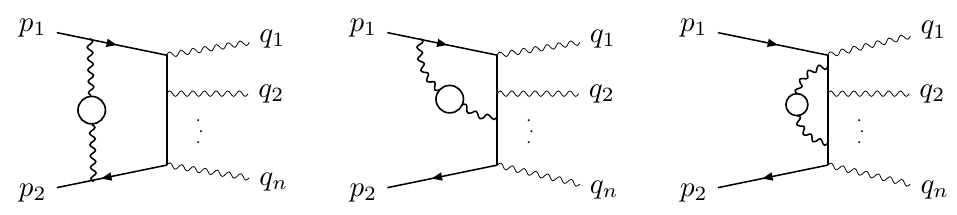
Figure 6. A class of diagrams that contribute to M (2)